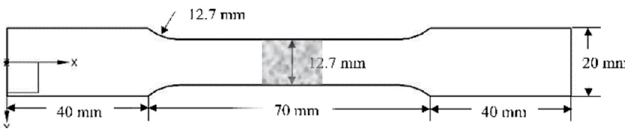
Figure 2. Schematic of tensile test samples.